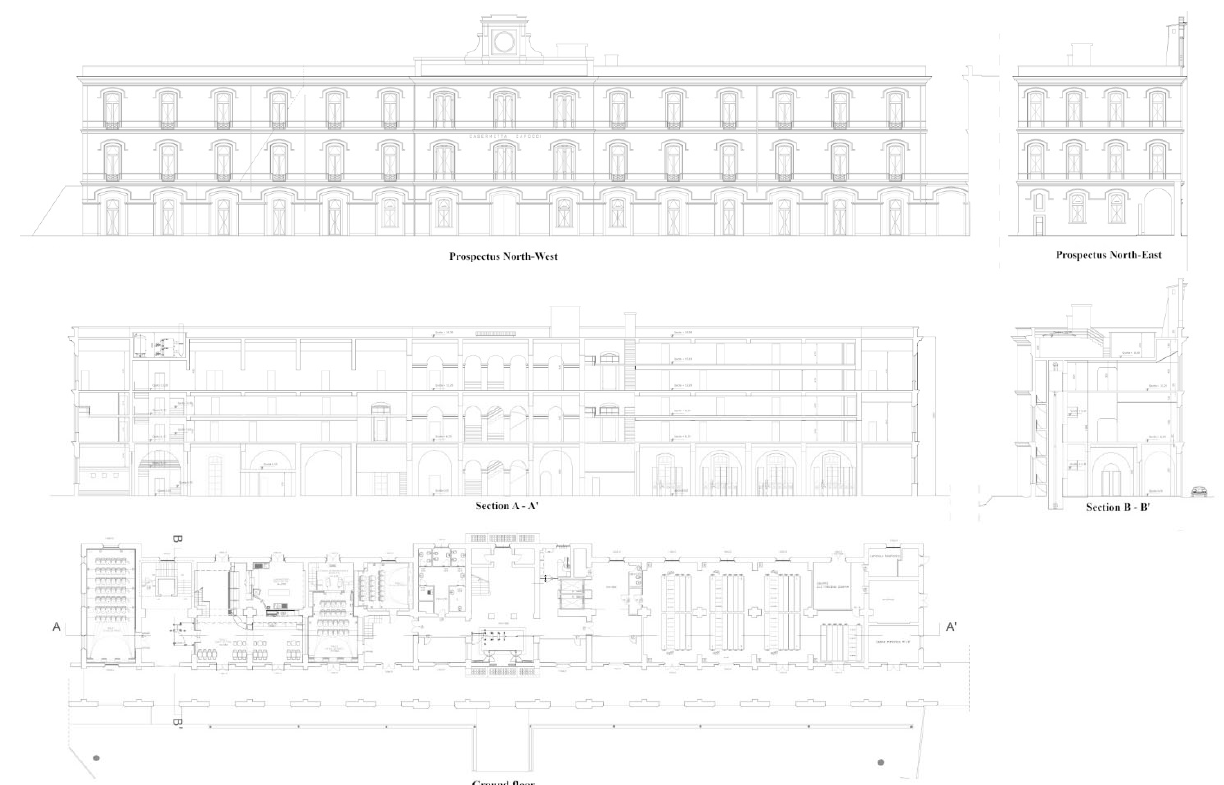
Figure 3. From top to bottom: north ‐ western and north ‐ eastern façades; vertical section A–A’ and B–B’; horizontal section of an example floor (ground floor).